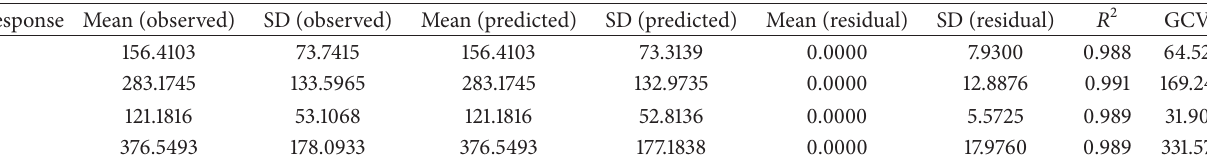
Table 4: MARS regression